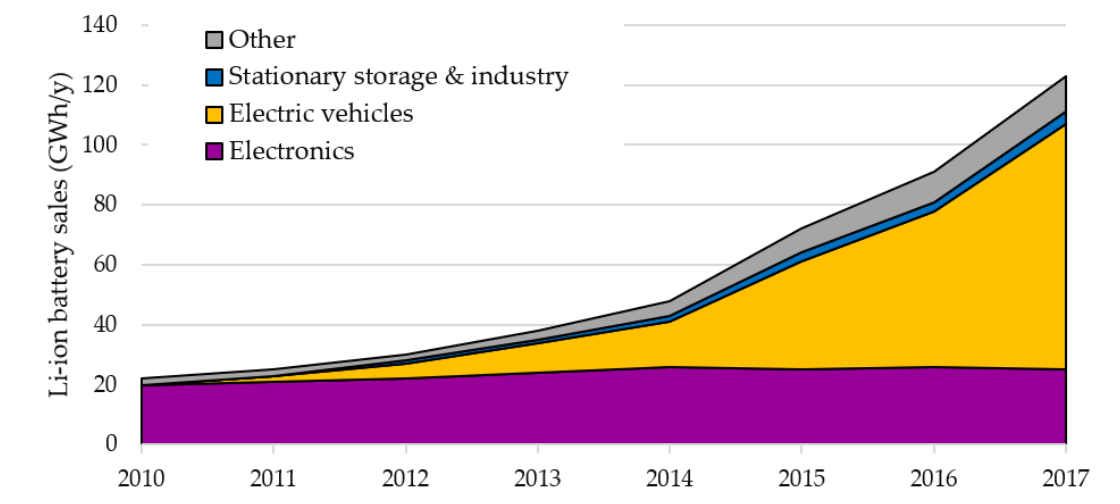
Figure 1. Evolution of Li-ion battery sales per application. Authors’ elaboration on